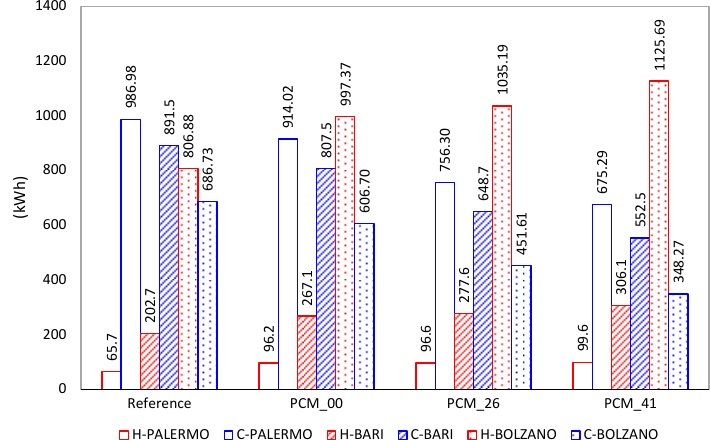
Appl. Sci. 2021 , 11 , x FOR PEER REVIEW Figure 16. Annual energy need for heating (H) and cooling (C). Figure 16. Annual energy need for heating (H) and cooling (C).